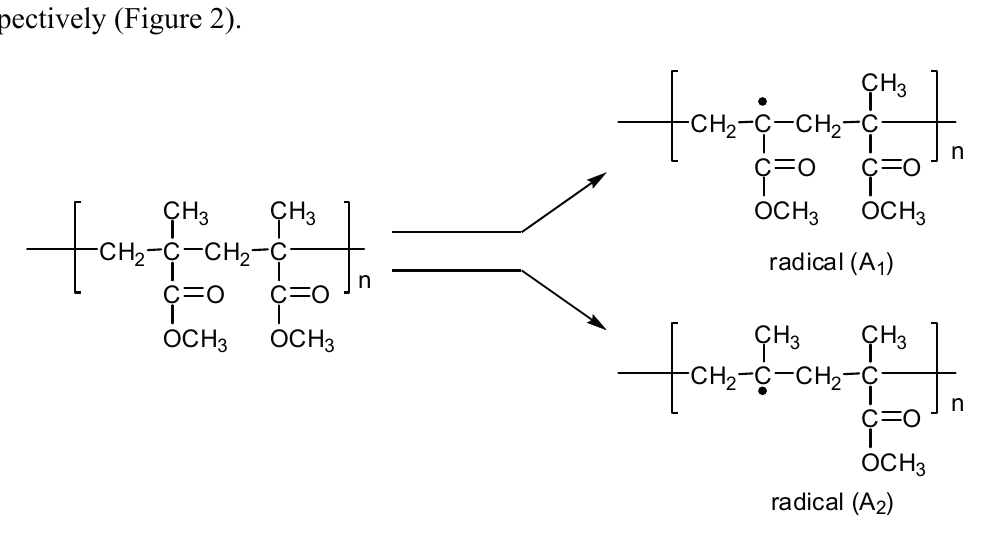
Figure 2. Formation of radicals A 1 and A 2